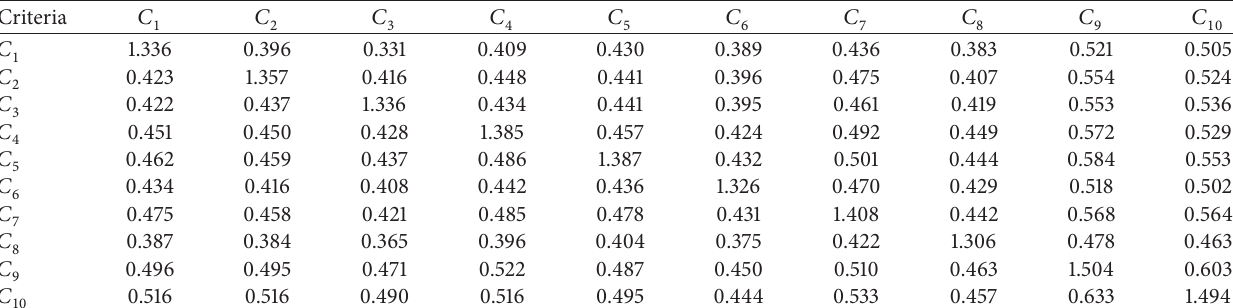
Table 2: The normalized direct-influence matrix G .